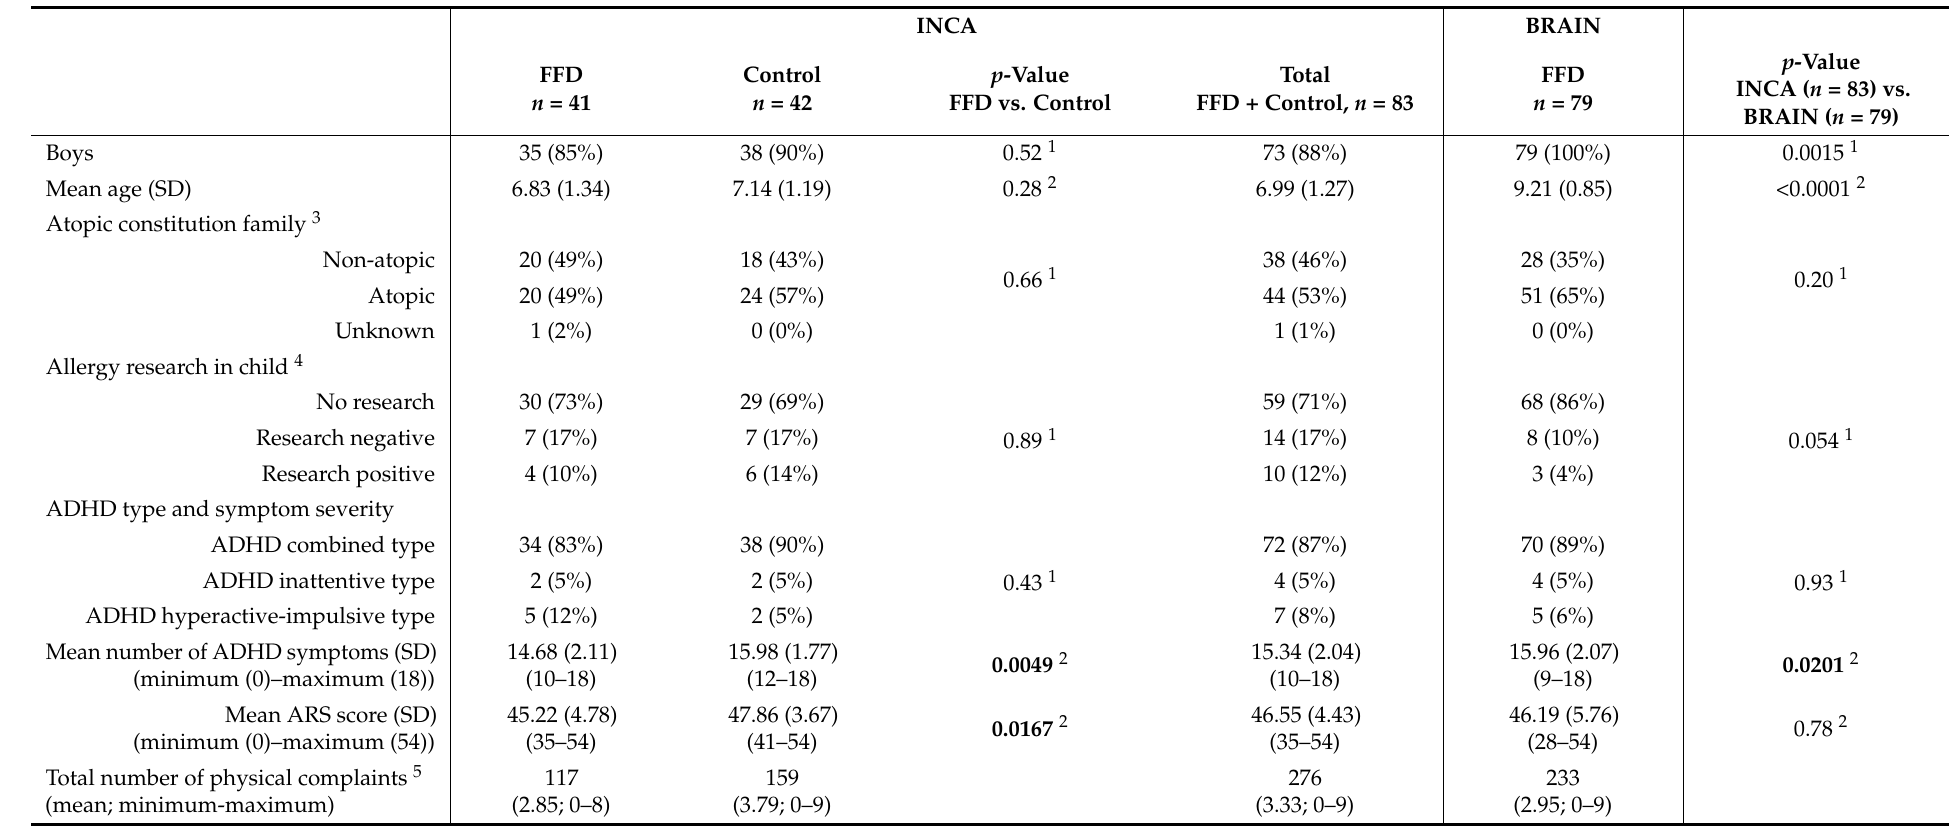
Table 2. Baseline (T start ) characteristics of children included in the INCA study and BRAIN